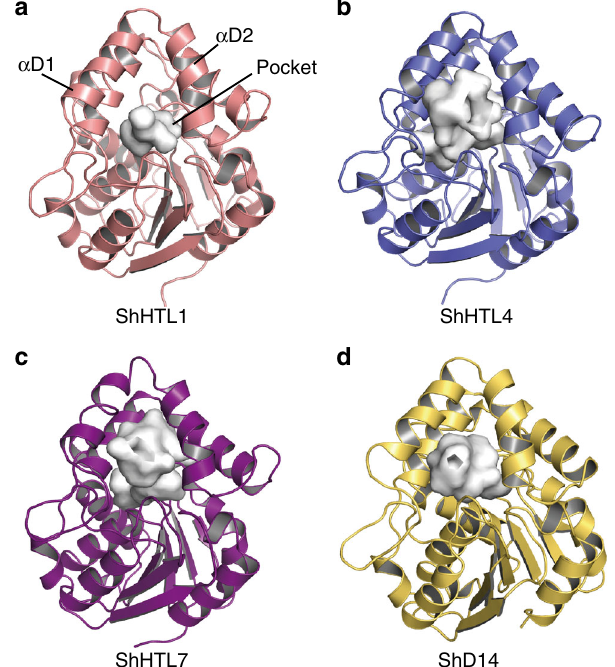
Fig. 2 Overall structures of ShHTLs and ShD14. a – d Structures of ShHTL1 ( a ), ShHTL4 ( b ), ShHTL7 ( c ), and ShD14 ( d ) are colored pink, slate blue, purple, and yellow, respectively. The ligand-binding pockets are shown in